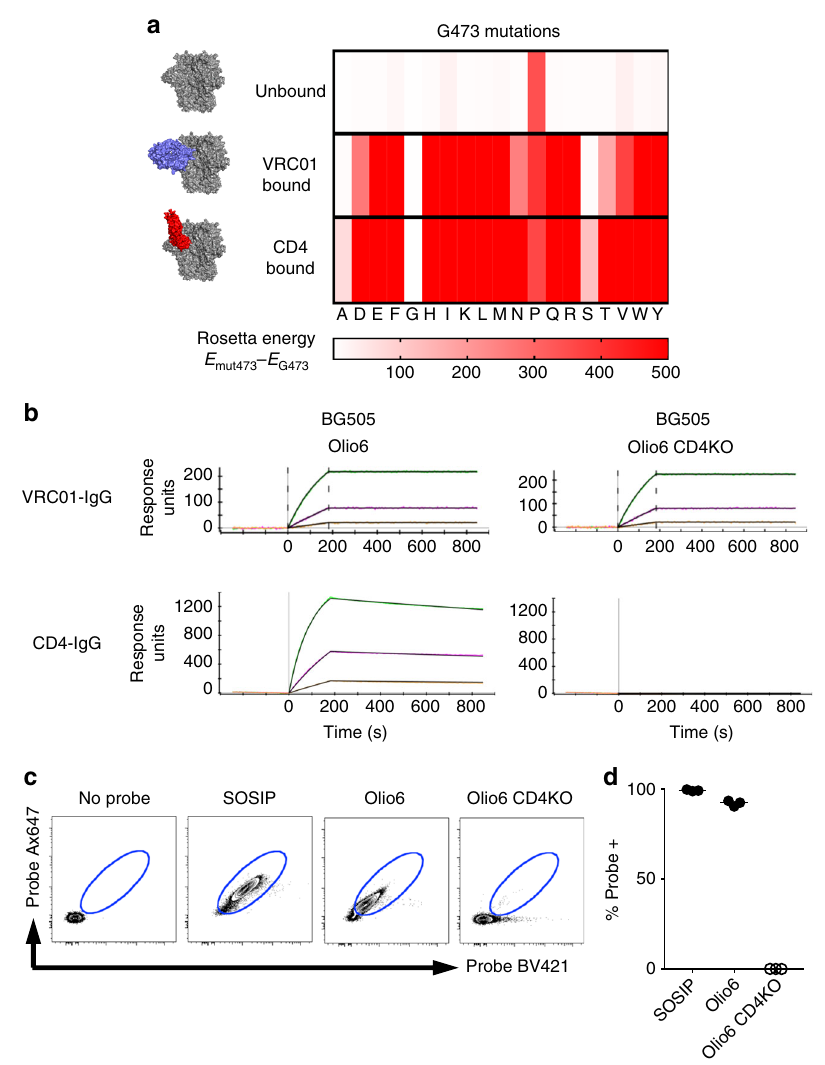
Fig. 2 Design and evaluation of the CD4-KO mutation. a The difference in computed Rosetta energy between trimers with glycine at position 473 and all 20 amino acids except cysteine at position 473 in three states: unbound, VRC01-bound, and CD4-bound. Energies are colored from white to red, with energies similar to glycine in white and unfavorable energies in red. b SPR binding of trimers to VRC01-IgG and CD4-IgG. IgGs were ligands and trimers were analytes. c Binding of different trimers to CD4 + T cells. Fluorescently labeled Env trimer probes were mixed with human PBMC. All panels gated on CD4 + T cells. Blue oval gate indicated probe positive population. A ‘ no probe ’ staining was used as a negative control to set the lower bound of the positive gate. d Frequency of Env trimer probe positive CD4 + T cells. N = 3 individual human donor samples for each probe. The data are representative of